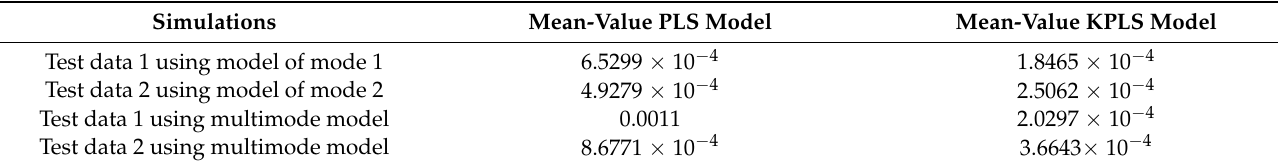
Table 3. RMSE values obtained using the mean-value PLS and mean-value KPLS